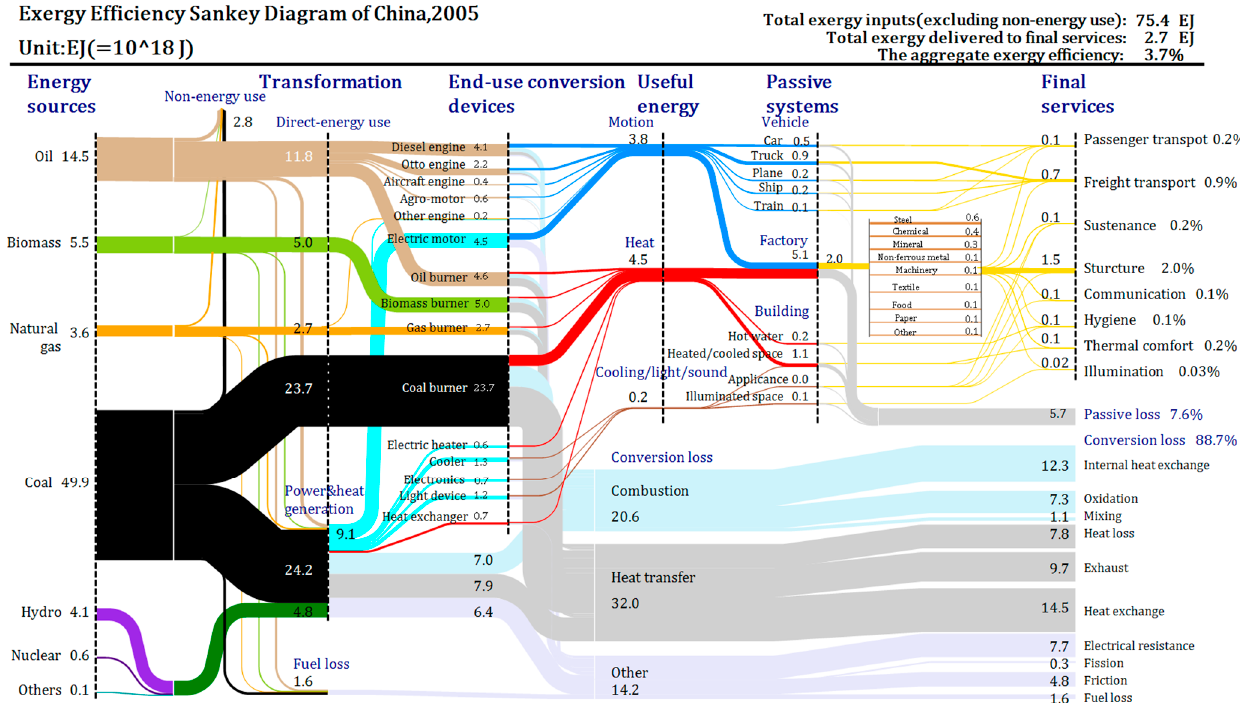
Figure 5. Exergy efficiency Sankey diagram from the energy source to final service of China in 2005.